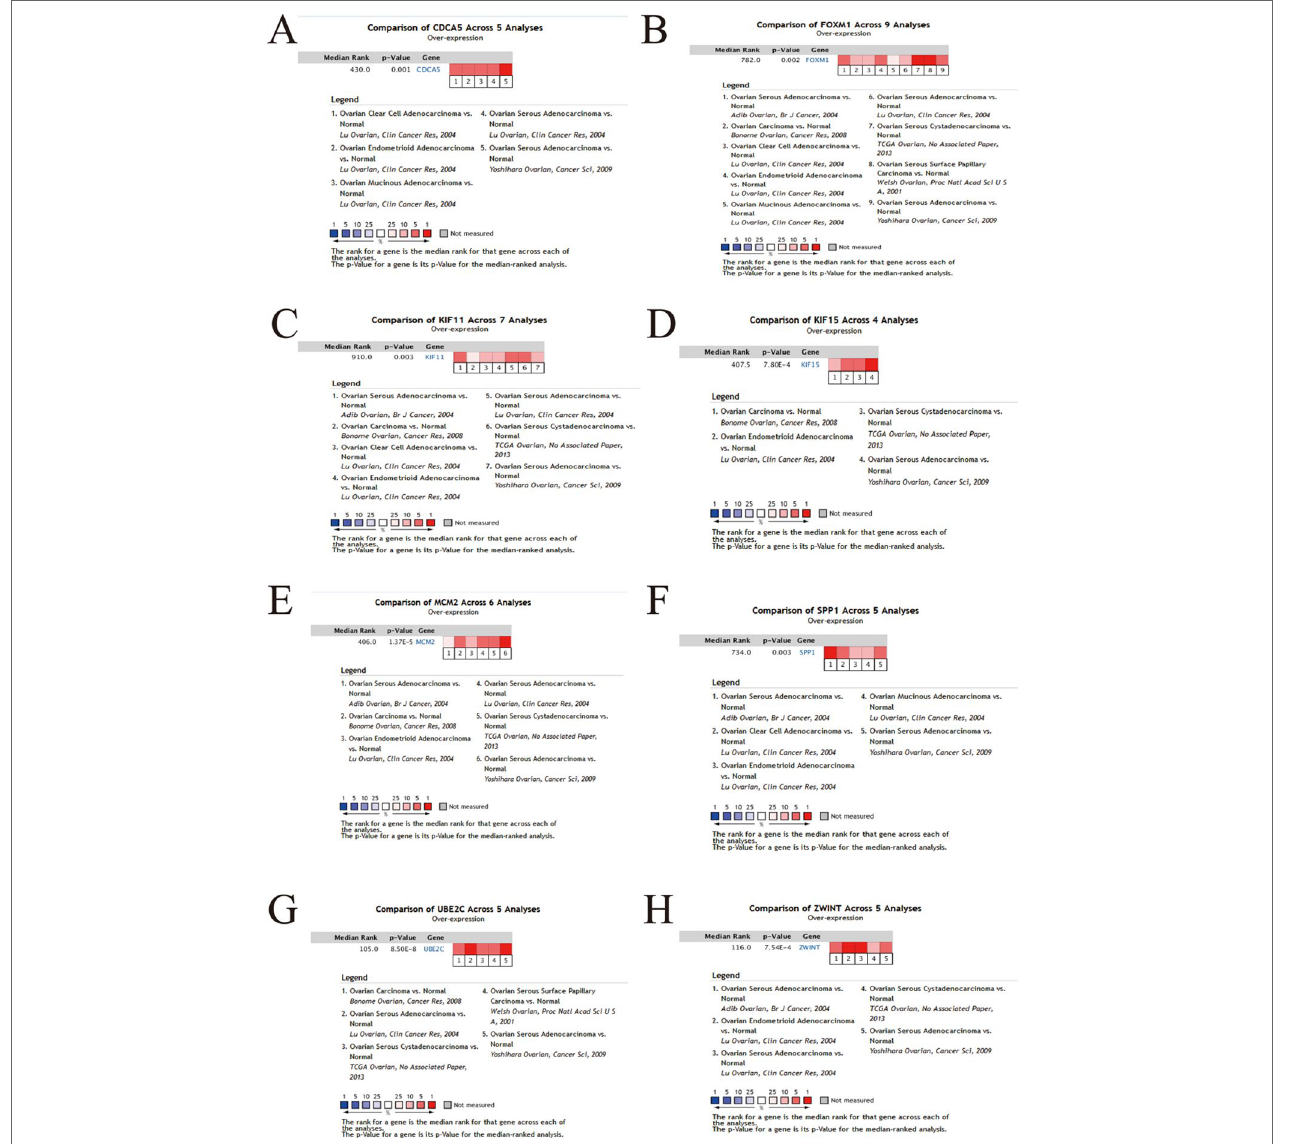
FIgUrE 11 | Eight hub genes expression within EOC across multiple datasets by Oncomine. (A) CDCA5, (B) FOXM1, (C) KIF11, (D) KIF15, (E) MCM2, (F) SPP1, (g) UBE2C, (h) ZWINT.